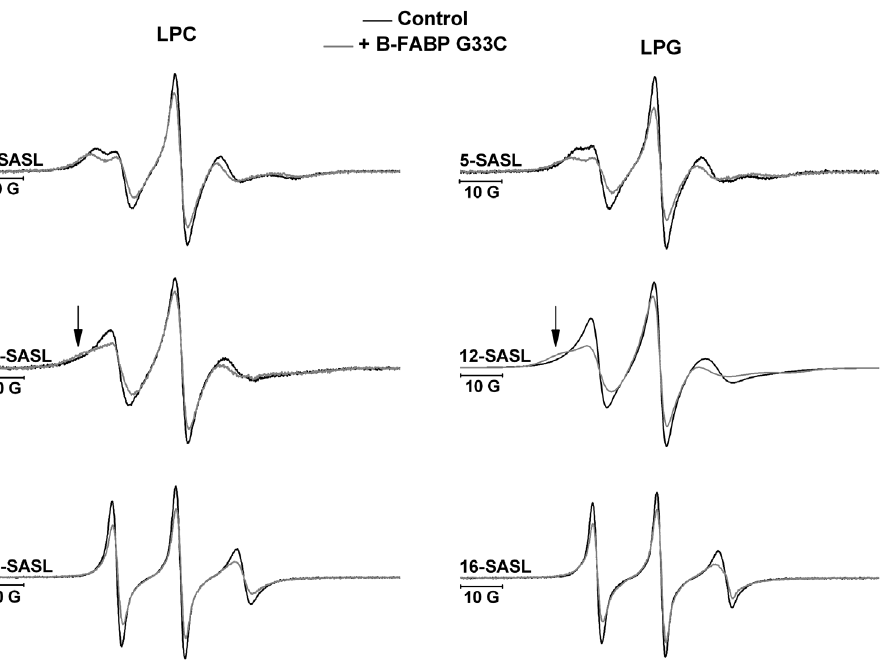
Figure 6. ESR spectra of 5- (top), 12- (middle) and 16-SASL (bottom) incorporated in LPC (left) or LPG (right) micelles. Black lines are the control experiments and gray lines are the spectrum after addition of G33C B-FABP. Changes in lineshape are clearly seen in all cases when mutant G33R1 is added to either LPC or LPG micelles, indicating a less mobile environment around the n -SASL probe in the presence of G33R1 B- FABP. The arrow denotes the more immobilized population in the 12-SASL spectrum.